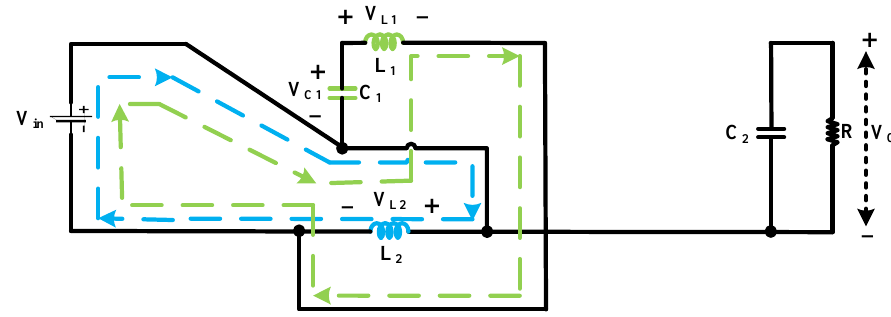
Figure 2. Conduction diagram for the first mode of operation.